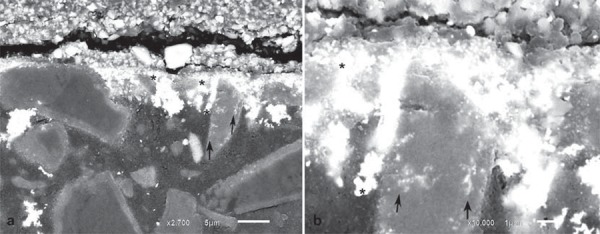
Backscattered electron micrographs of Durafill VS resin impregnated with silver. a) Extensive silver penetration over the first µm of the surface (x2,700). Note penetration of silver particles around fillers (*) and inside pre-polymerized filler particles (arrows). b) Higher magnification of the same area (x10,000)